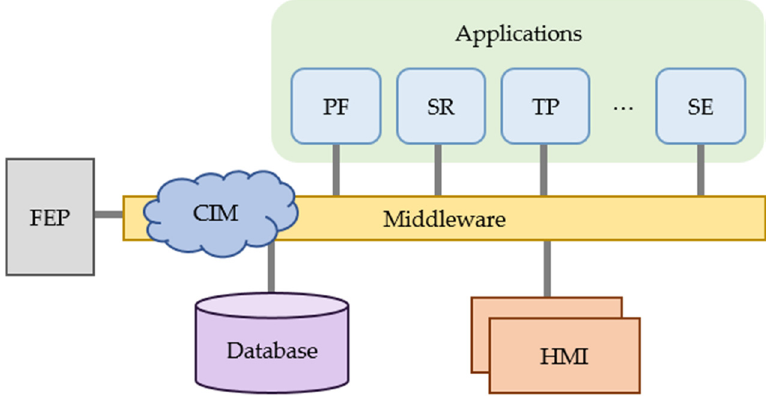
Figure 2. Components of the control center in an EMS.